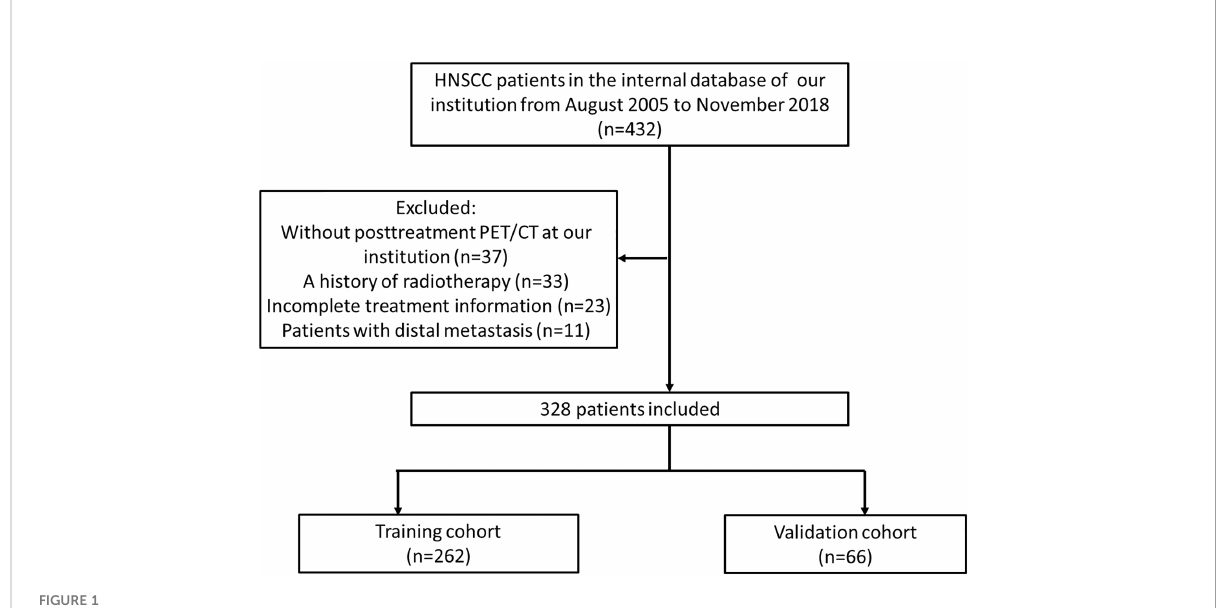
FIGURE 1 Diagram of the patients included in this